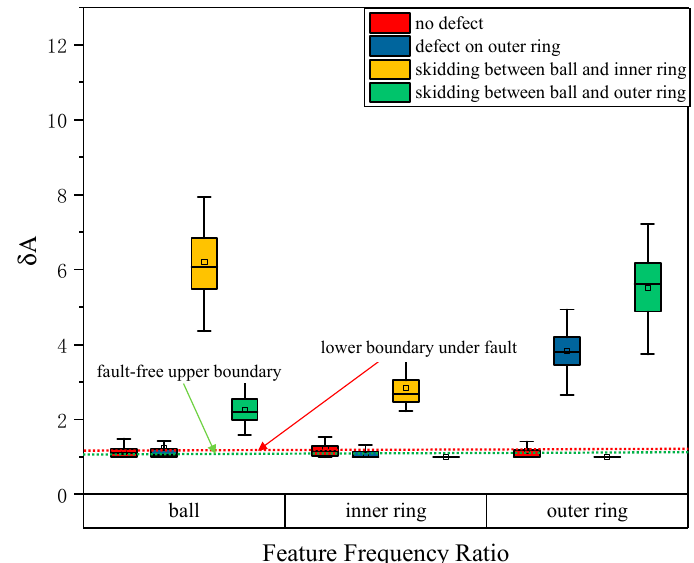
Figure 10. Box-plot diagram of the corrected characteristic frequency ratios of various faults